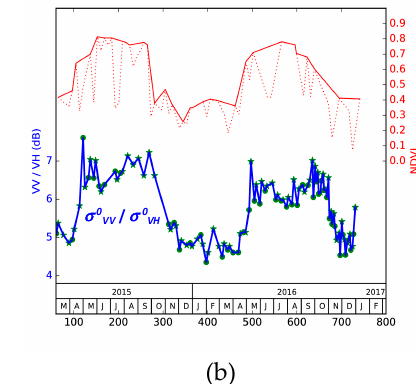
VV/VH Figure 5. Temporal profiles of σ 0 observed over an oak stand. ( a ) 𝜎 (cid:3023)(cid:3023)(cid:2868) , 𝜎 (cid:3023)(cid:3009)(cid:2868) , and 𝜎 (cid:3023)(cid:3023)(cid:2868) /𝜎 (cid:3023)(cid:3009)(cid:2868) are represented in blue, magenta, and green, respectively. In situ precipitation is also shown (cyan) ; ascending and descending passes measurements are plotted as “•” and “*”, respectively. ( b ) Landsat-8 Operational Land Imager (OLI)-derived Normalized Difference Vegetation Index (NDVI) (– raw data; — maximum value over a sliding 48-day period) overlaid on σ 0